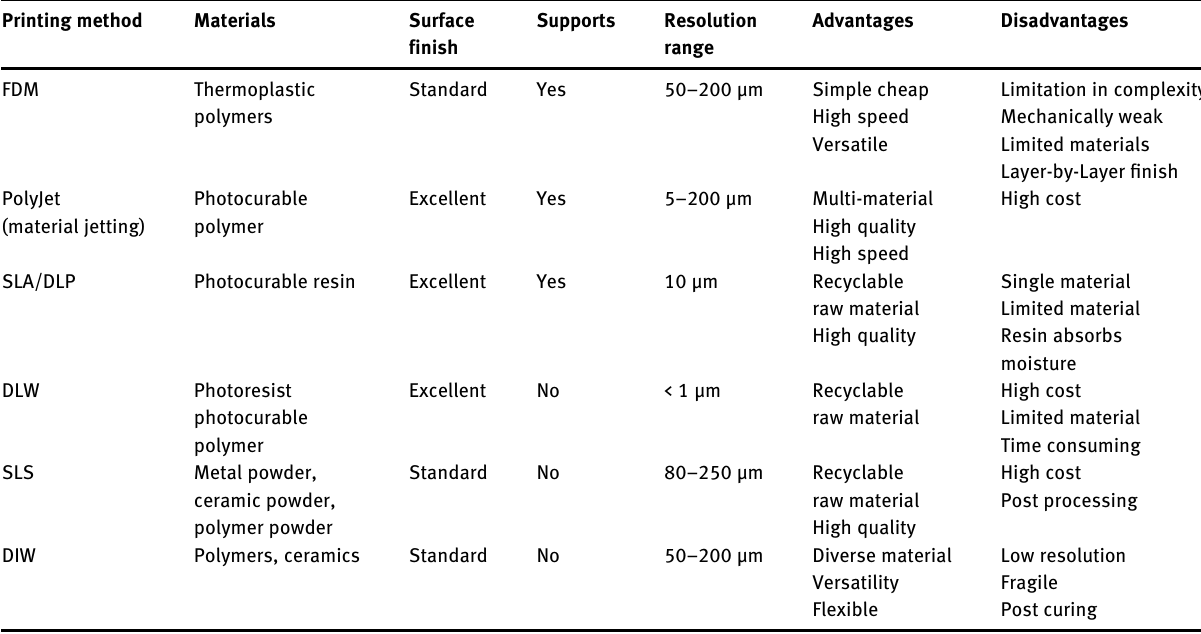
Table  : Types of  D printing and its characteristics. Printing